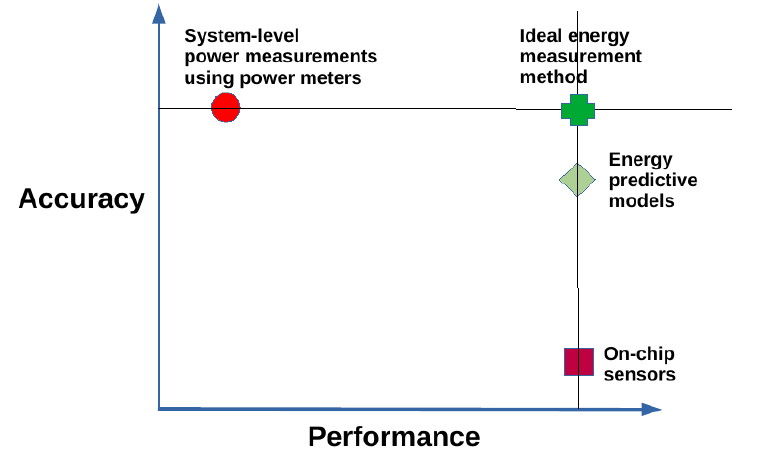
Figure 12. The accuracy and performance tradeoffs between the different energy measurement methods to construct the dynamic energy profiles. Methods employing the ground truth (system- level power measurements using power meters) have the highest accuracy but the lowest performance. On the other hand, methods based on on-chip power sensors exhibit the ideal performance but also the lowest accuracy. The method based on energy predictive models exhibits a good trade-off between these two